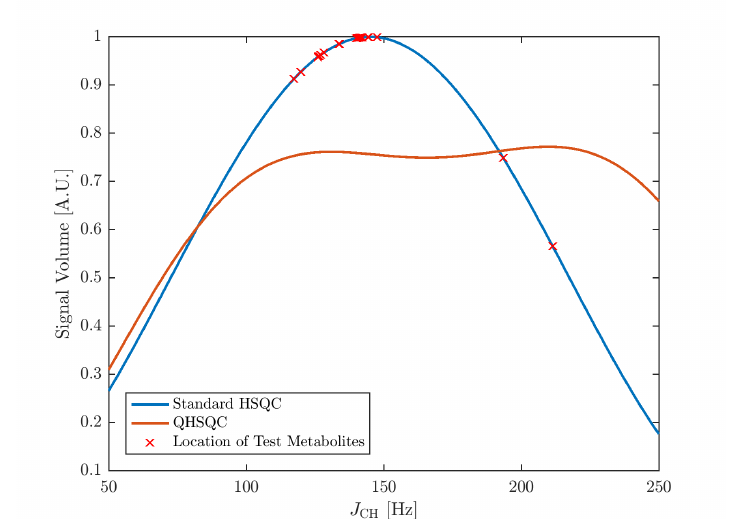
Figure 1. Dependency of 1 H- 13 C-HSQC cross-peak signal volumes on the scalar coupling constant J CH for a standard HSQC experiment with an INEPT delay ∆ = 3.40 ms in blue and a Q-HSQC experiment with INEPT delays of ∆ 1 = 2.94 and ∆ 2 = 5.92 ms, respectively, at a ratio of 3:1 in orange. The crosses indicate the J CH -coupling values of 20 signals of the metabolites in the used model mixture (see Materials and Methods section for